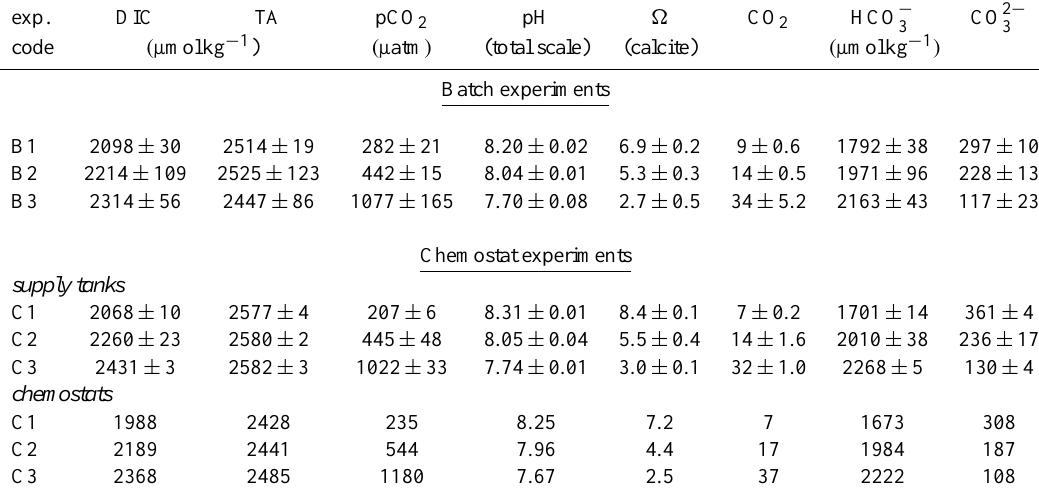
Table 1. Carbonate system parameters from the batch and chemostat experiments. Values from the batch cultures are expressed as mean values with according standard deviation calculated from start and end measurements of the experiments (1SD, n = 6). Values from the reservoir tanks (chemostat experiments) are expressed as mean with according standard deviation under equilibrium conditions (1SD, n = 5). exp. DIC TA pCO 2 pH (cid:127) CO 2